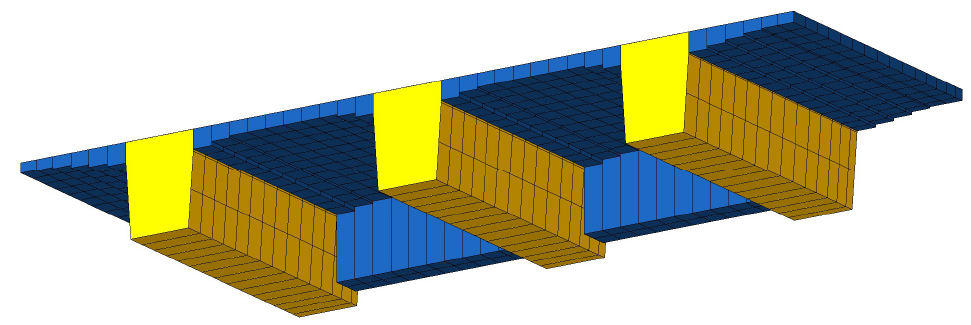
Figure 11. Division of the model into finite elements: beams (yellow) and plates (blue).